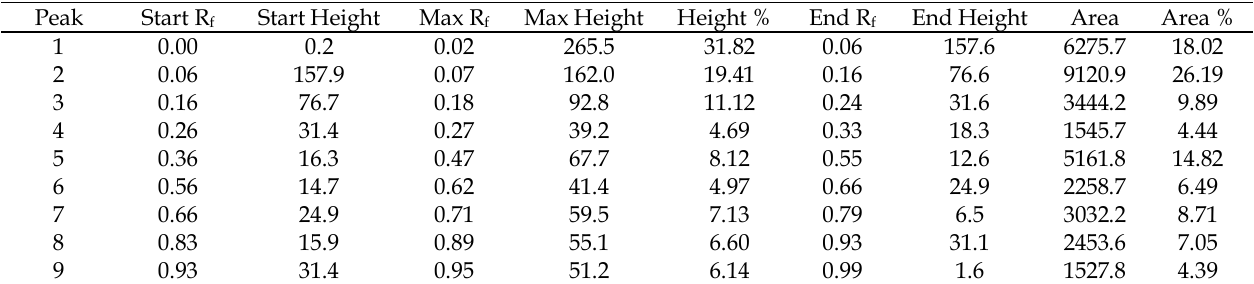
Table 10b. R f value, No. of Peaks, peak area and height of hydroalcholic extract of O. tenuiflorum in Toluene: Ethyl acetate at 366